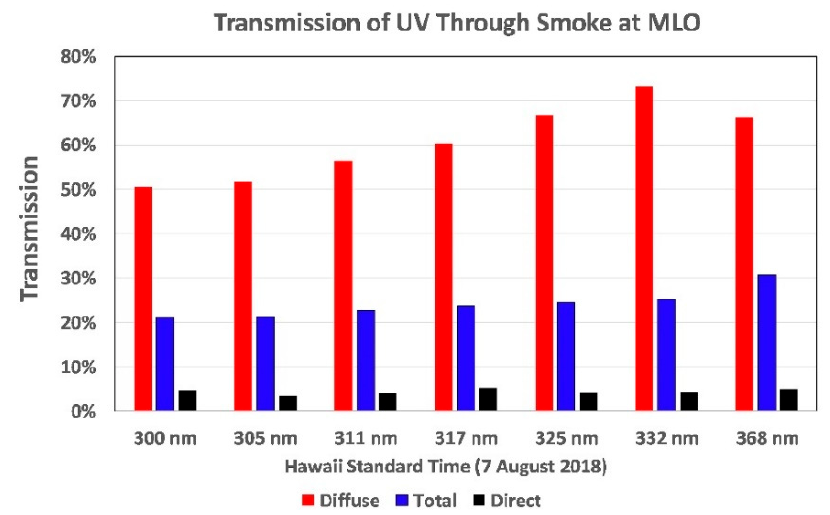
Figure 13. Wavelength-dependent transmission of solar UVR measured by a 7-channel rotating shadowband radiometer during a rare smoke event over the Mauna Loa Observatory.